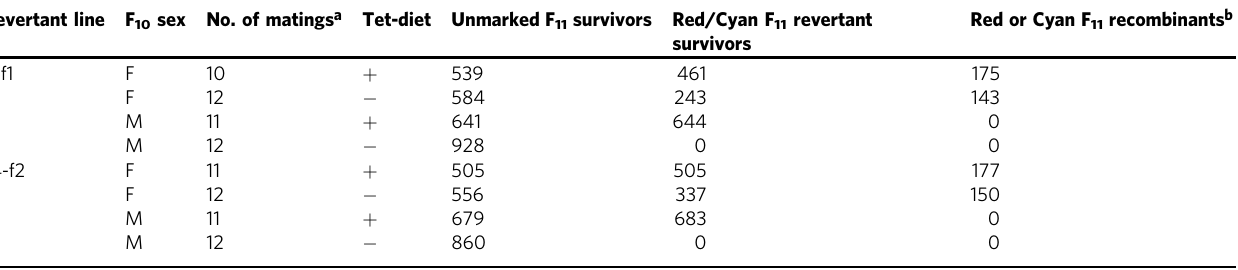
Table 3 Revertant lethal line F 10 females or males backcrossed to w [m] exhibiting maternal effect F 11 survival on Tet-free